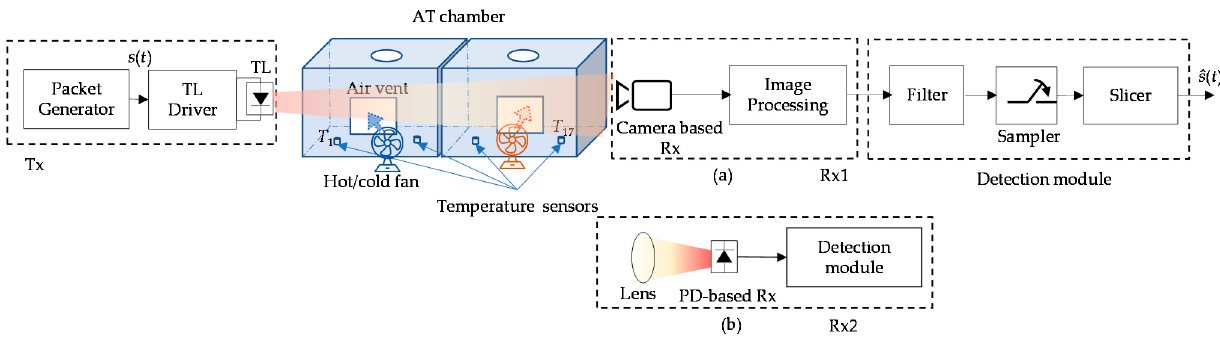
Figure 3. Setup of experimental investigation on AT effects on the vehicular visible light communications (VVLC) link with: ( a ) the camera and ( b ) the photodiode (PD) optical receiver